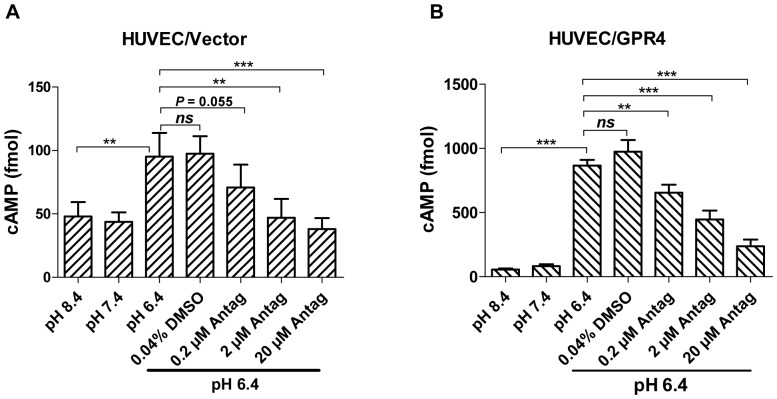
Inhibition of acidosis/GPR4-induced cAMP production by the GPR4 antagonist in HUVEC.(A–B) HUVEC/Vector and HUVEC/GPR4 cells were treated with varying pH in the presence or absence of the GPR4 antagonist EIDIP. After the pH treatment, intracellular cAMP was measured as described in the Materials and Methods. The vehicle control had 0.04% DMSO which is the same DMSO concentration as that in 20 µM GPR4 antagonist. The results are the average of 10 samples for HUVEC/Vector cells and 7 samples for HUVEC/GPR4 cells. Error bars indicate the mean ± SEM. **, P<0.01; ***, P<0.001; ns, not significant.